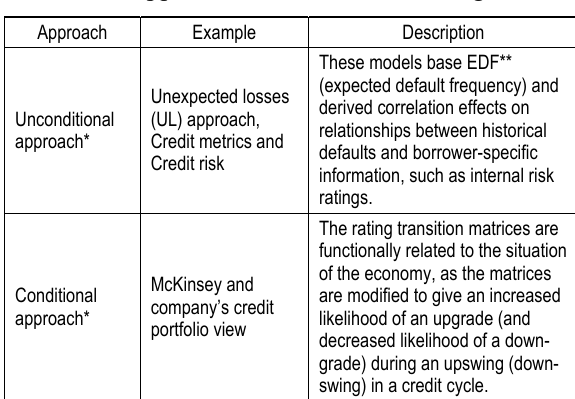
Table 1. Approaches of credit risk